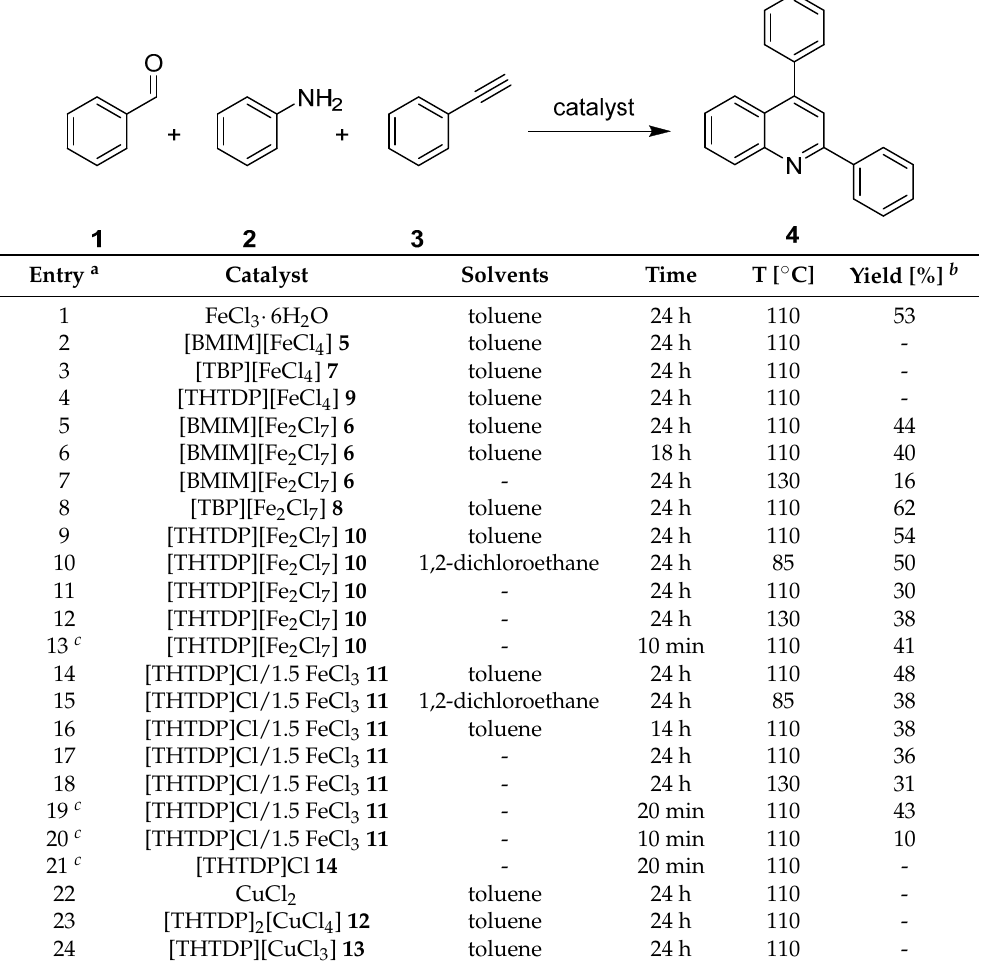
Table 1. Reaction of benzaldehyde 1 , aniline 2 and phenylacetylene 3 to 2,4-phenylquinoline 4 .